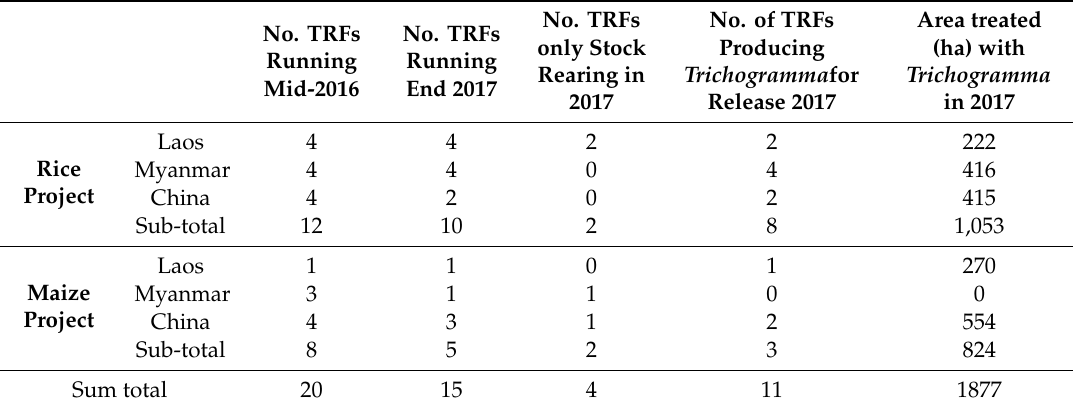
Table 3. Situation of TRFs established within the maize and rice integrated pest management (IPM) projects during the last year of the project (mid-2016) and by the end of